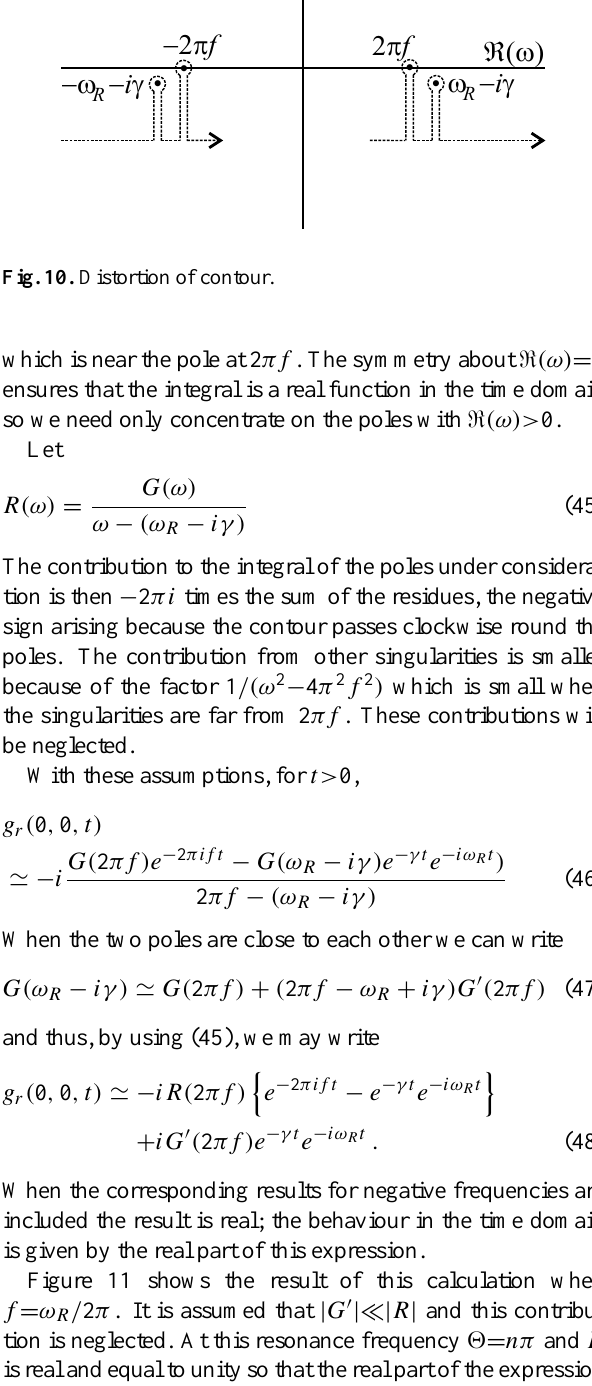
Fig. 9. Transmission coefficient in the complex plane when the effect of the resonance is taken into account and the magnetosheath plasma is in motion. The full contours represent amplitude with the ticks showing the downhill direction. The contours are drawn for log | R | = 0 . 1 n where n = 0 , ± 1 , ± 2 , ± 3 ,... . The heavy dotted line is a branch cut. The dashed lines 30 ◦ intervals.